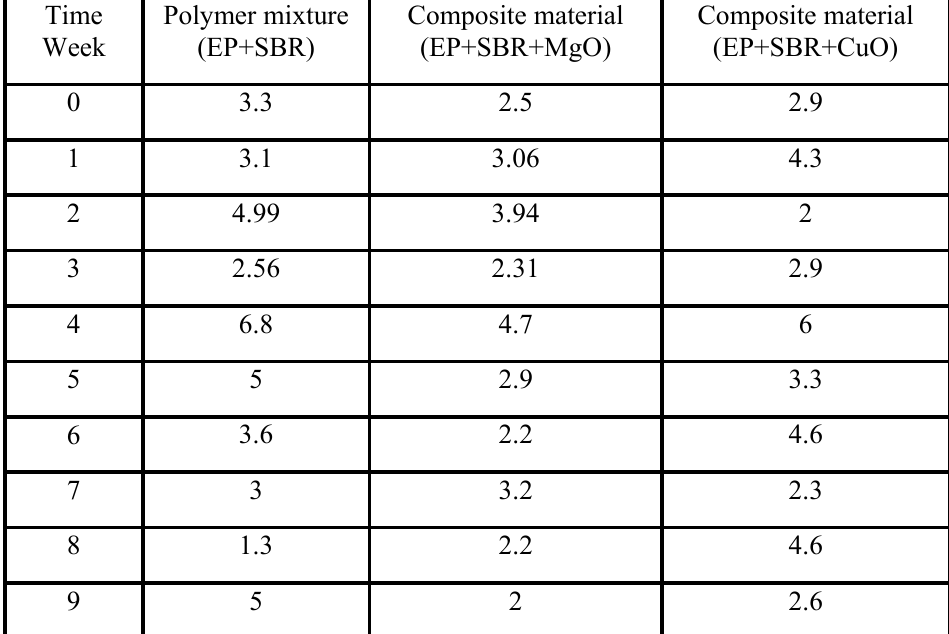
Table 2: The values of impact resistance.